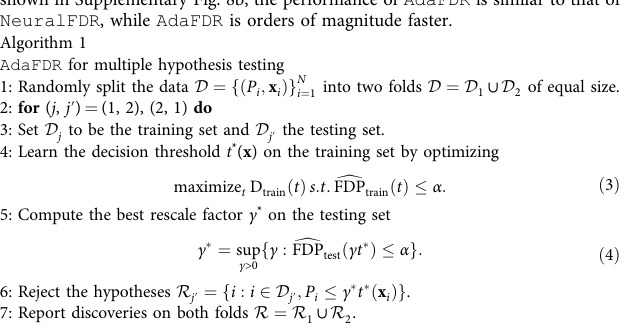
Algorithm 1 AdaFDR for multiple hypothesis